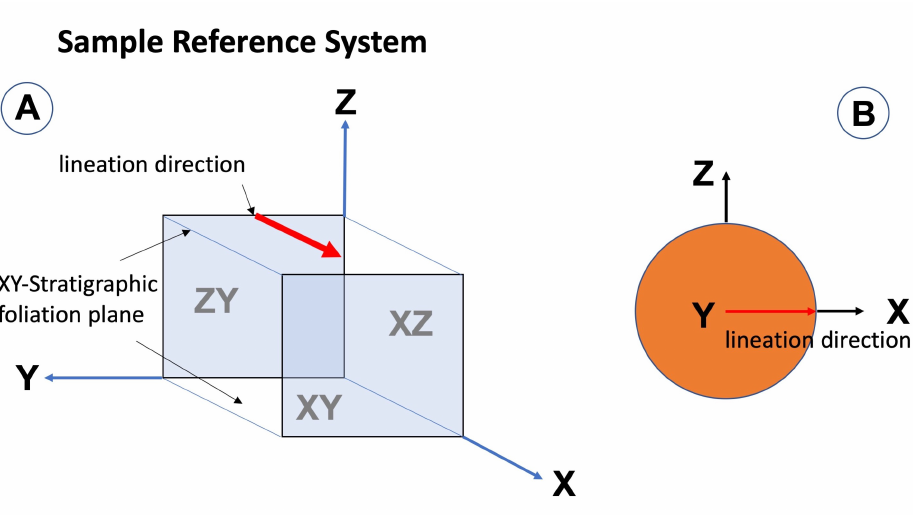
Figure 3. Sample reference system and pole figure representation. ( A ) sample reference system showing a simplified cubic sample with respect to the orthogonal reference. X, Y, and Z axes are shown ( B ); Pole figure reference representation with X, Y, and Z axes.